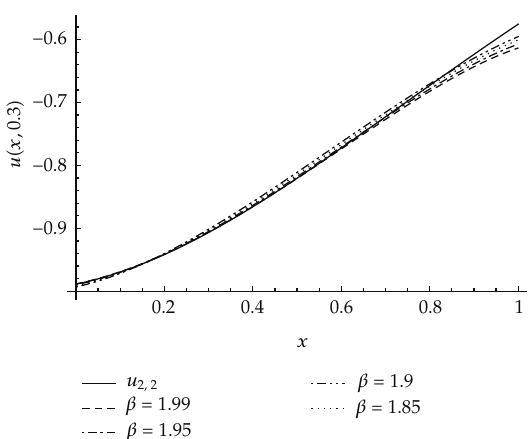
Figure 5: u (cid:2) x, 0 . 3 (cid:3) of Example 4.2 Case 2 for 4th-order HPM approximation as parameterized by β .